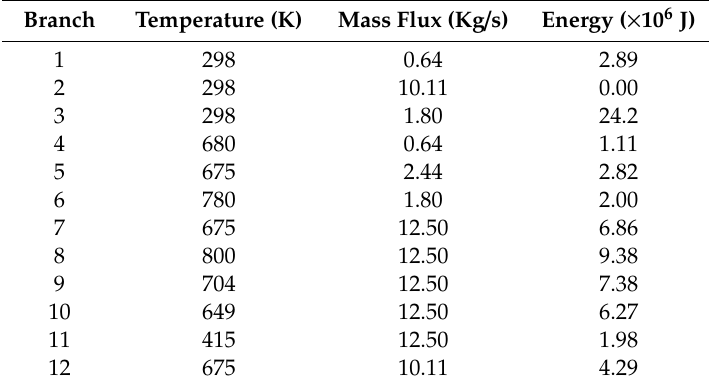
Table 1. Typical results for the optimized system.